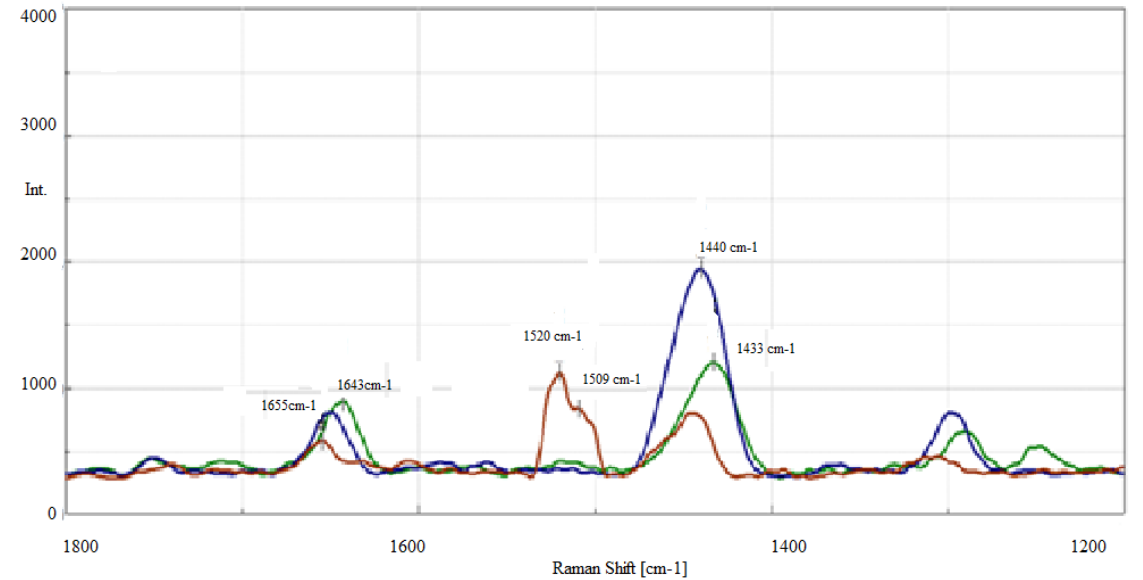
Figure 4. Raman spectra of AF grease—green line, AF_120 grease, oxidised at 120 °C—brown line and AF_G oz grease after anti-wear test—blue line, in the 1800–1200 cm − 1 range.